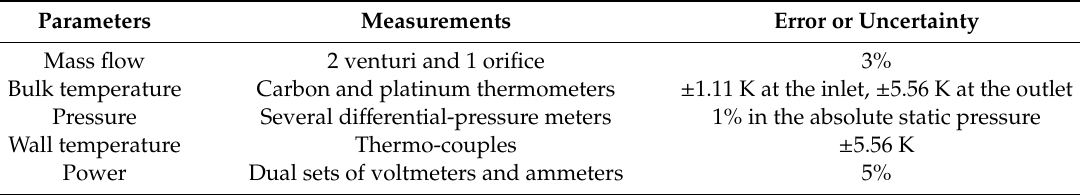
Table A3. The measurements and their errors or uncertainties of the parameters in the